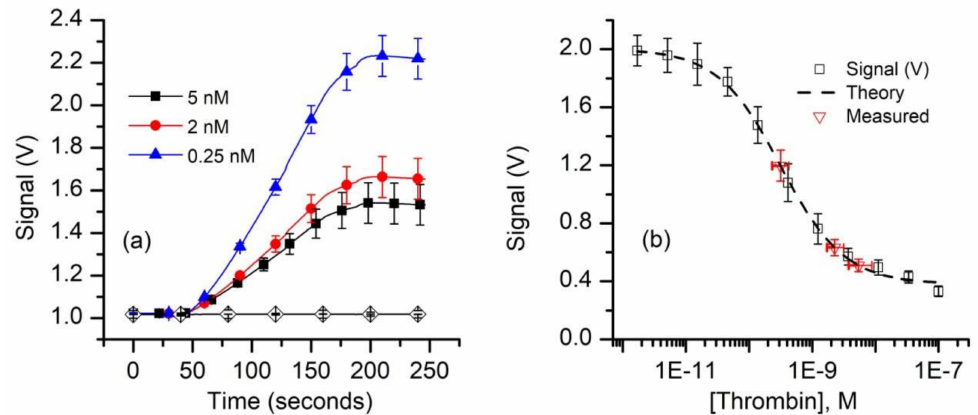
Figure 5. Equilibrium measurements of thrombin concentration by kinetic exclusion assay. ( a ) The raw fluorescence signal recorded for thrombin concentrations of 0.25 nM, 2 nM, and 5 nM (n = 3, ± SD) in equilibrated mixtures at a constant FA concentration of 50 pM. The symbols were added to facilitate curve discrimination and identification. ( b ) The end signal values measured against the baseline for standard and mock samples (symbols) were plotted and fitted (dashed line) with the four-parameter logistic equation (Equation (A2)) to determine the unknowns. The range of concentrations represented by the x error bars on the “measured” data points represent concentrations corresponding to the average measured signal (n = 3) ± SD of the measured